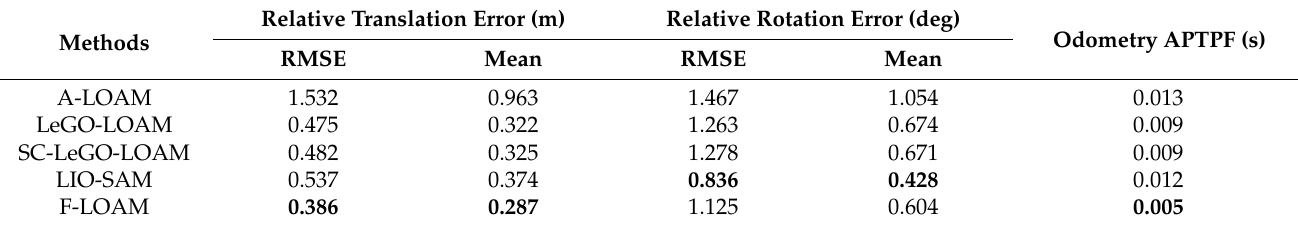
Table 6. Performance comparison of five